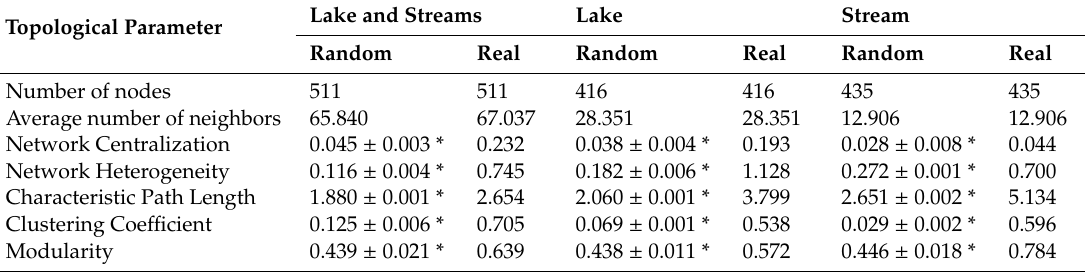
Table 2. Topological parameters of real co-occurrence networks and corresponding random networks (some parameters of the random network are shown in mean ± SD. SD represent standard deviation). t -tests were used to compare the topological parameters between real and random networks.